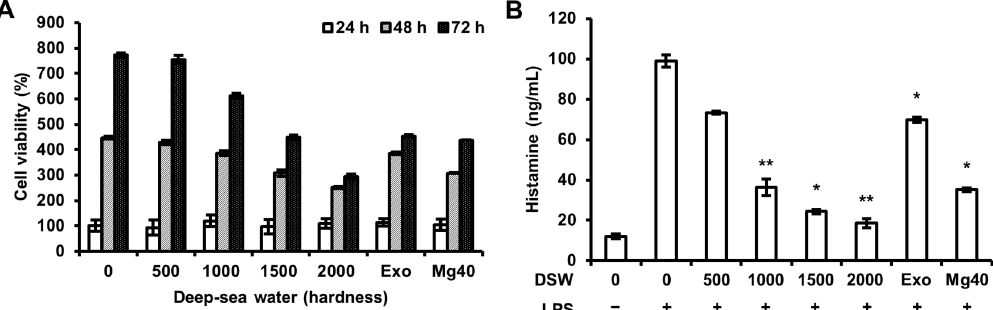
Figure 1. Effect of RDSW on cell viability and histamine release in LPS-treated RAW 264.7 macrophage cells. ( A ) Cells were treated with various hardness (0, 500, 1000, 1500, and 2000) of RDSW for 24, 48, or 72 h, and cell viabilities were assessed by SRB; ( B ) The release of histamine was measured in a conditioned medium. The cells were pre-treated with RDSW for 24 h prior to the stimulation of 1 µg/mL LPS for 24 h. All experiments were performed in triplicates, and data are shown as the mean ± SD. * p < 0.05 and ** p < 0.01 compared to LPS treatment only. Exo: hardness 1500 of exogenous Mg and Ca mixture, Mg:Ca = 3.5:1; Mg40: hardness 1500 of high Mg DSW, Mg:Ca = 40:1.